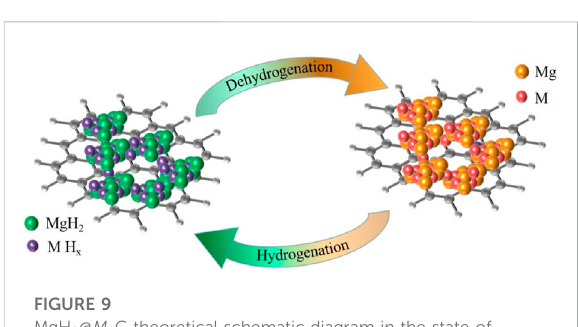
FIGURE 9 MgH 2 @ M 2 C theoretical schematic diagram in the state of complete hydrogen absorption and complete hydrogen